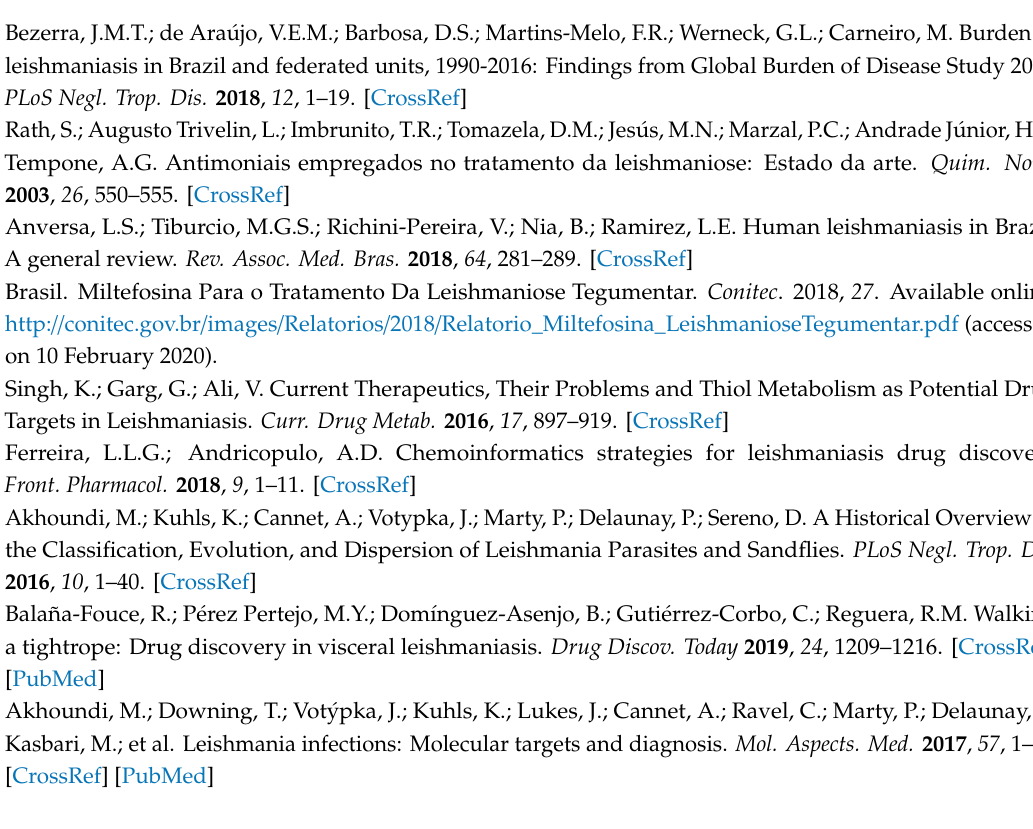
the active site, Figure S2: Alignment of the DHODH protein sequences. The gray regions show non-similar and non-identical amino acids. The red regions show identical amino acids. The yellow regions show similar amino acids. The black boxes indicate the active site, Figure S3: Alignment of the PTR1 protein sequences. The gray regions show non-similar and non-identical amino acids. The red regions show identical amino acids. The yellow regions show similar amino acids. The black boxes indicate the active site, Figure S4: Alignment of the TR protein sequences. The gray regions show non-similar and non-identical amino acids. The red regions show identical amino acids. The yellow regions show similar amino acids. The black boxes indicate the active site, Figure S5: Alignment of the UGPase protein sequences. The gray regions show non-similar and non-identical amino acids. The red regions show identical amino acids. The yellow regions show similar amino acids. The black boxes indicate the active site, Table S3: Average of all energy values (EM) obtained from the five scoring functions, for each lignan, and the probability value of potential consensus docking activity (PDC), for each studied enzyme in L. major. Absent values indicate the molecules that were eliminated during this evaluation, Table S4: Average of all energy values (EM) obtained from the five scoring functions, for each lignan, and the probability value of potential consensus docking activity (PDC), for each studied enzyme in L. braziliensis. Absent values indicate the molecules that were eliminated during this